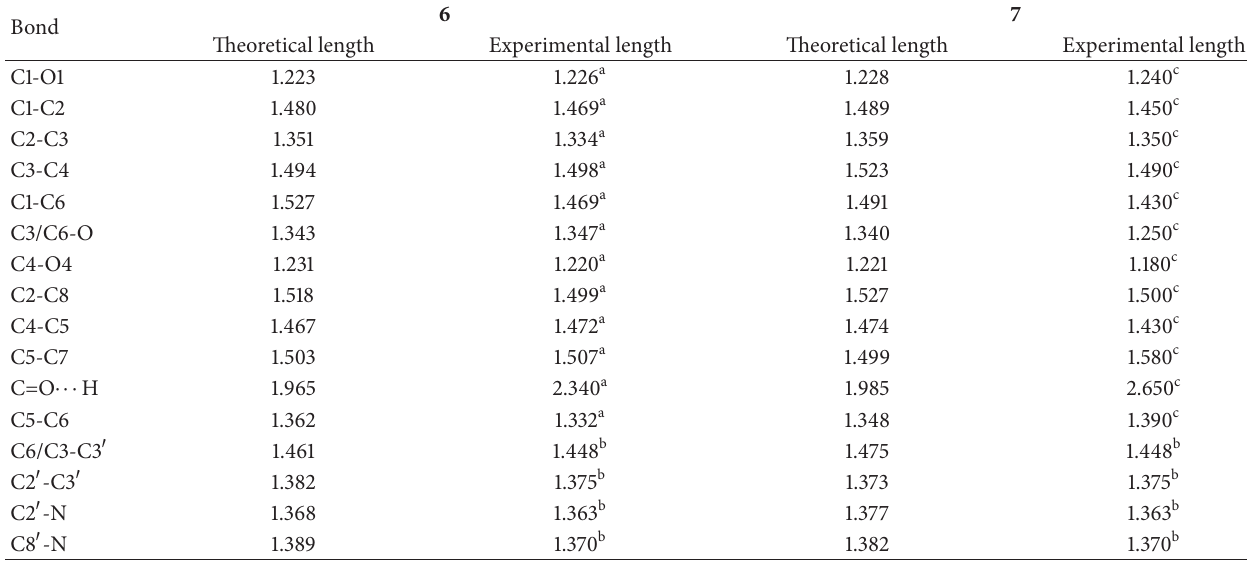
Table 2: Theoretical and experimental selected bond length (in angstrom) of 6 and 7 .